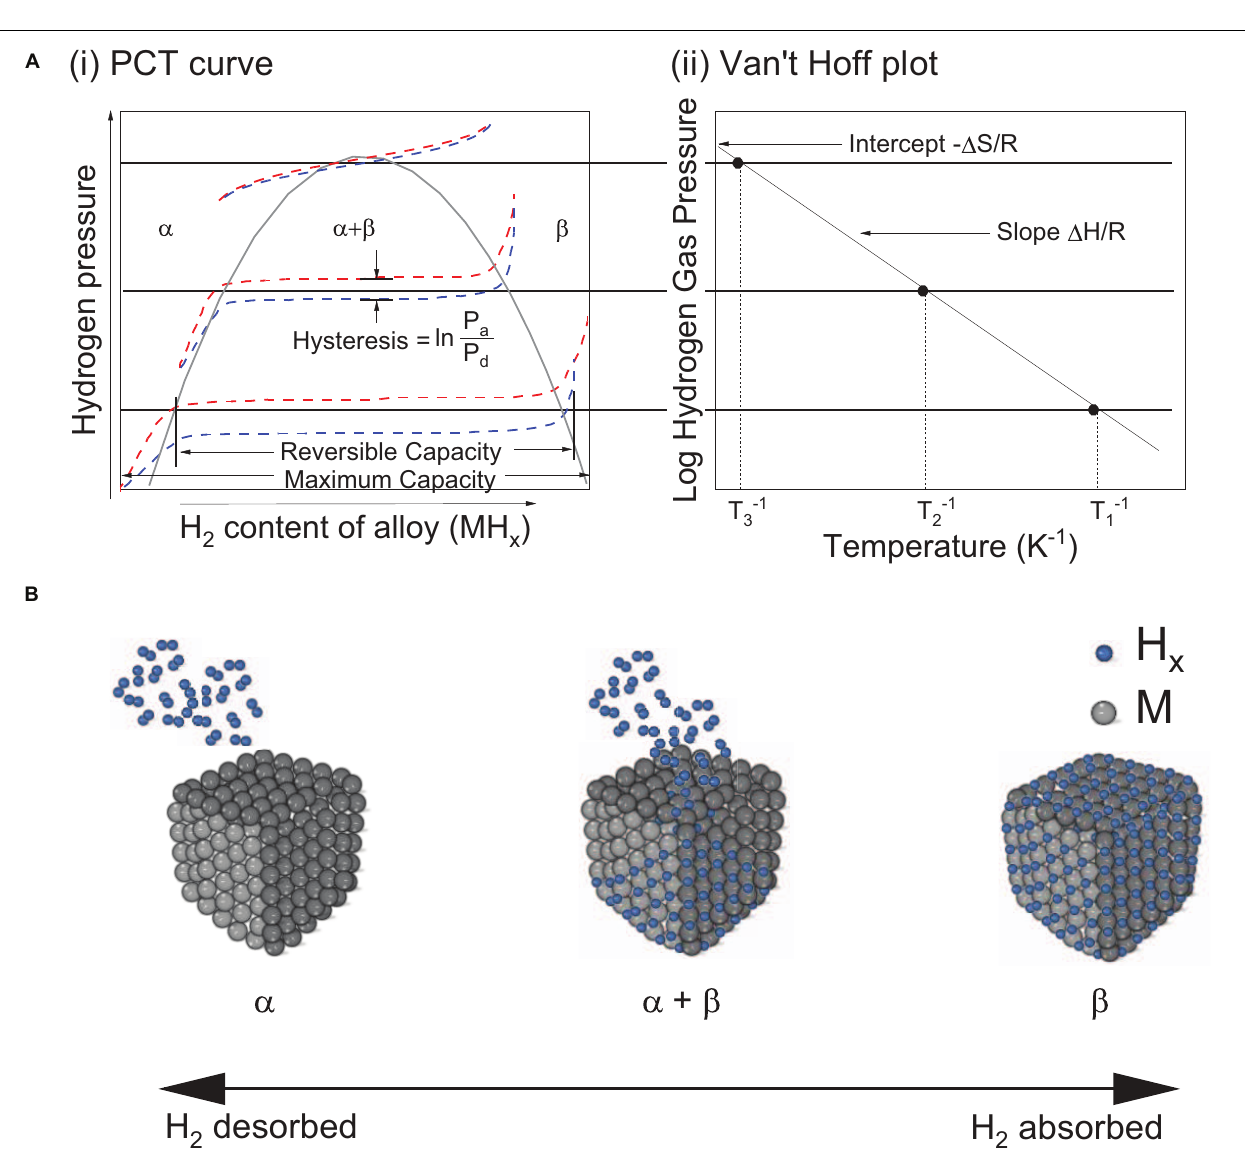
FIGURE 4 | (A) (i) Pressure-composition-temperature (PCT) curve, (ii) Van’t Hoff plot of a typical metal hydride based hydrogen storage (Klebanoff, 2012); (B) Physical representation of transition between phases as hydrogen is being absorbed or desorbed where α and β correspond to the metal and metal hydride phase,